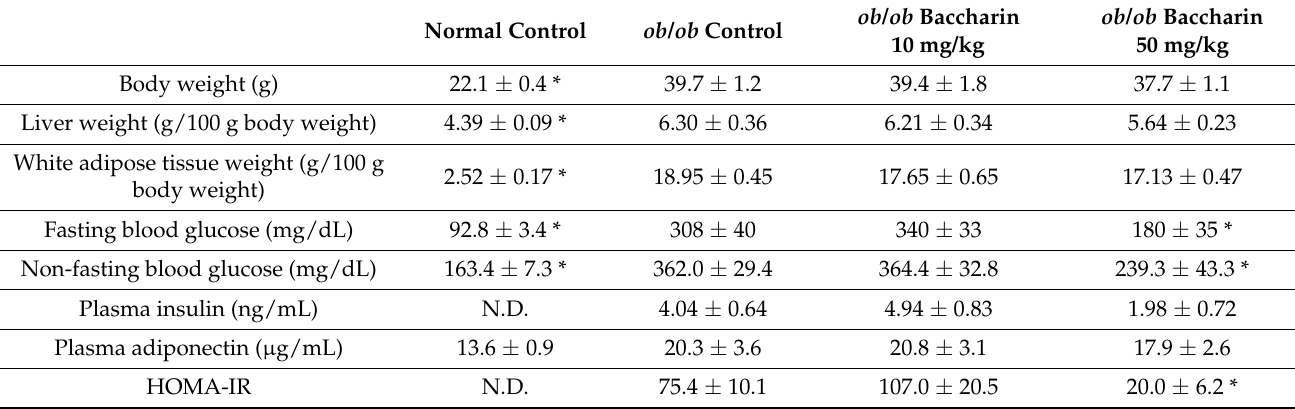
Table 1. Effects of baccharin on the body and organ weights and plasma biochemical parameters in normal and ob/ob mice. Normal Control